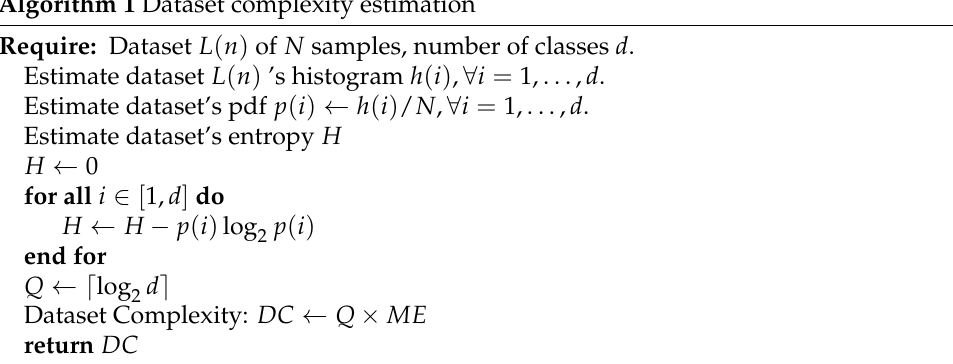
Algorithm 1 Dataset complexity